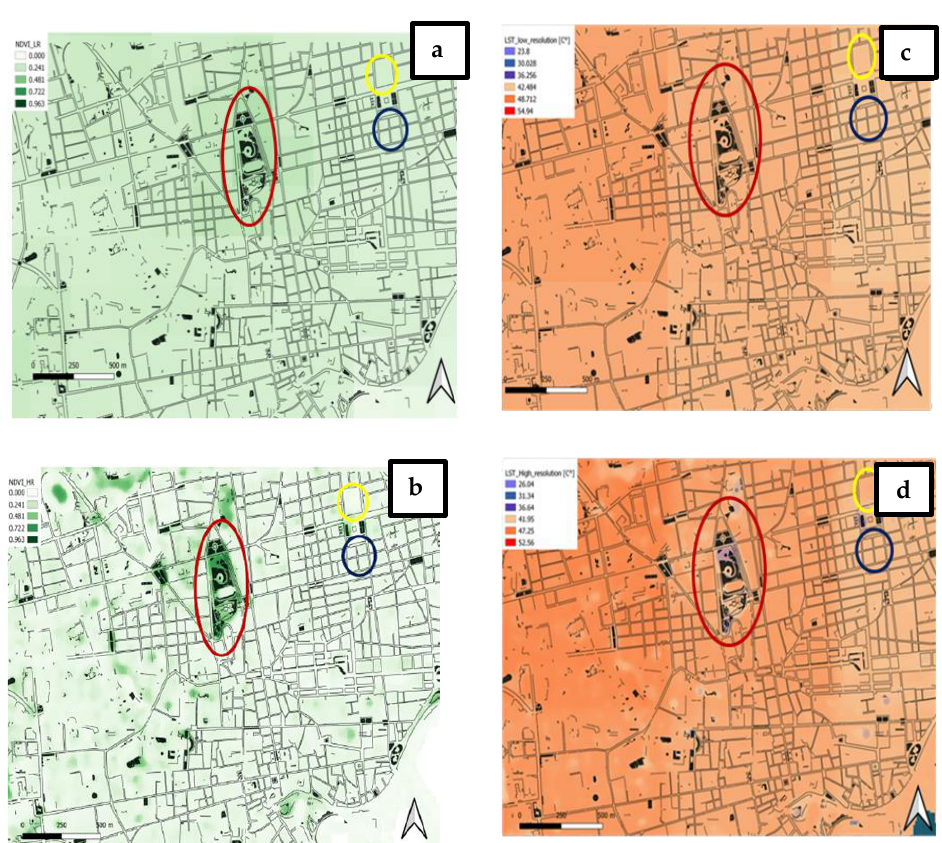
Figure 5. NDVI 250 ( a ), NDVI 10 ( b ), LST at low ( c ) and high resolution ( d ) on 14 July 2017. The red circle highlights Villa Bellini, the yellow circle the courthouse and the blue circle the skyscraper.